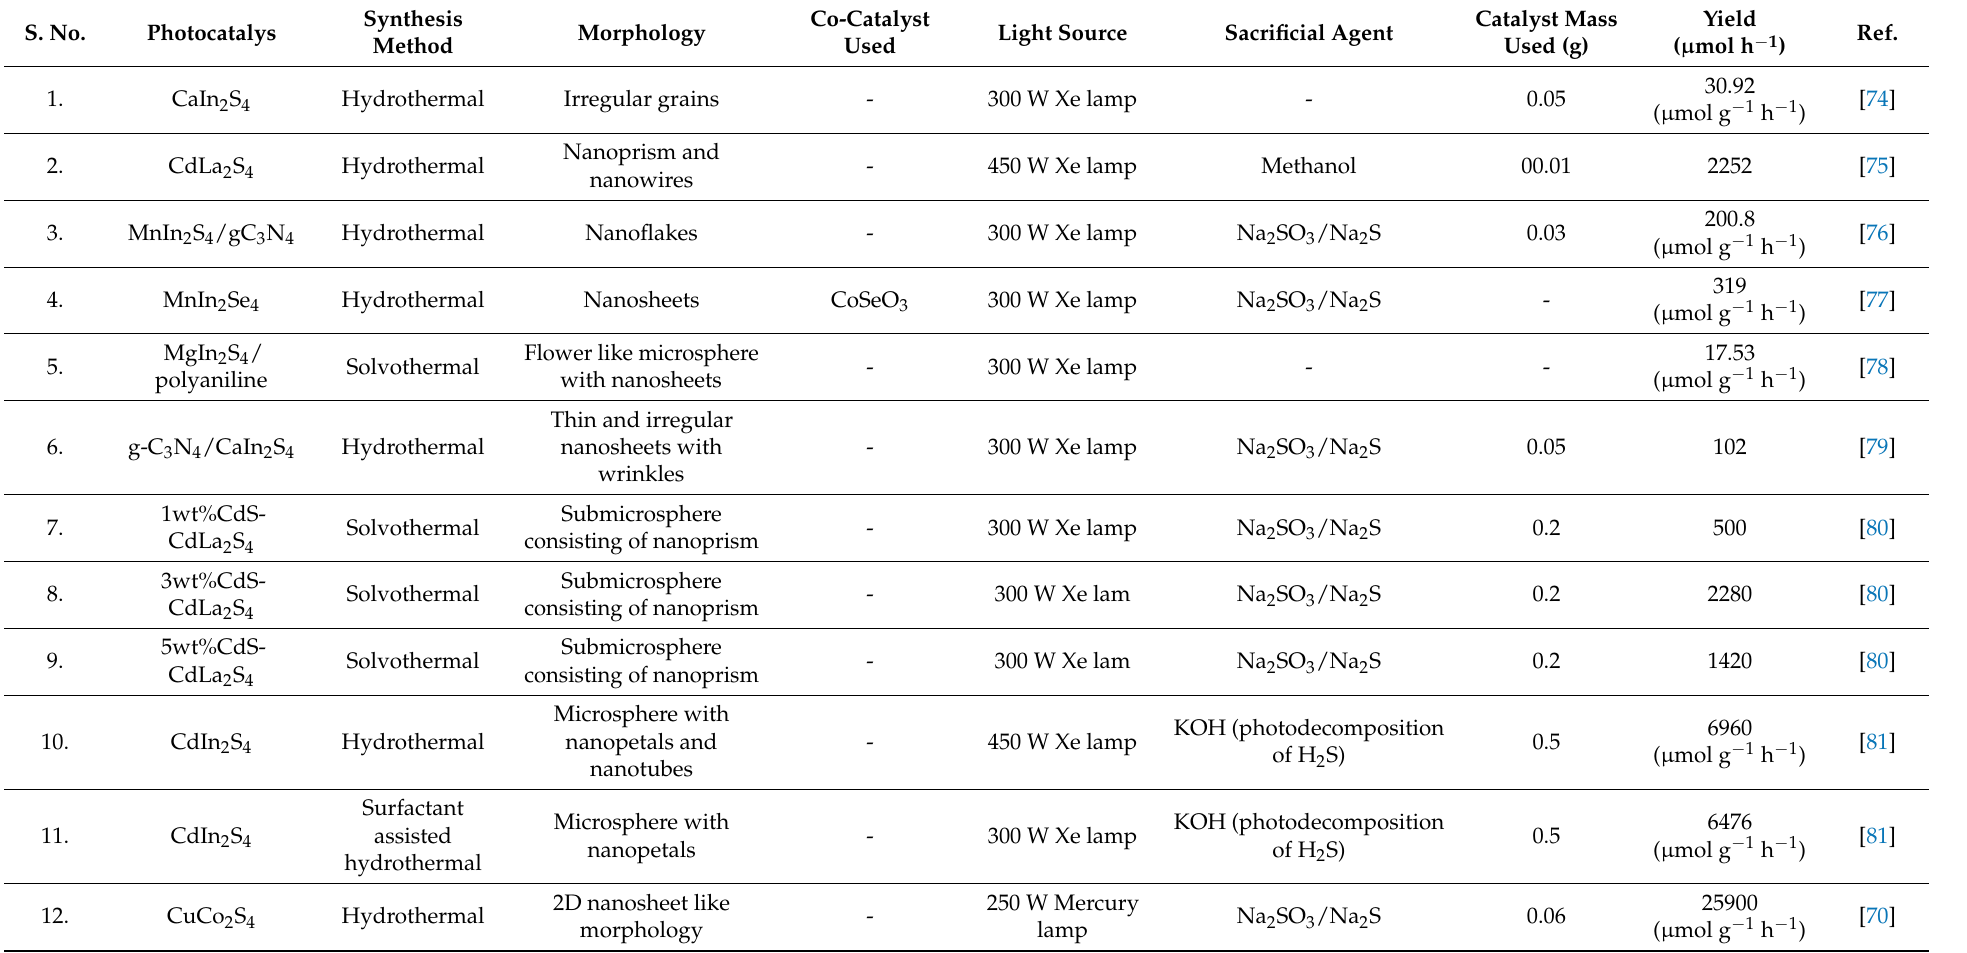
Table 2. Other ternary metal sulfides and composites for photocatalytic H 2 generation with respective parameters. S.